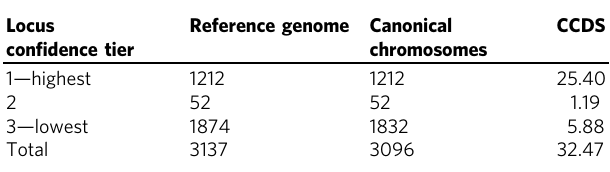
Table 4 Quantity in megabases of genomic regions in each locus con fi dence tier.